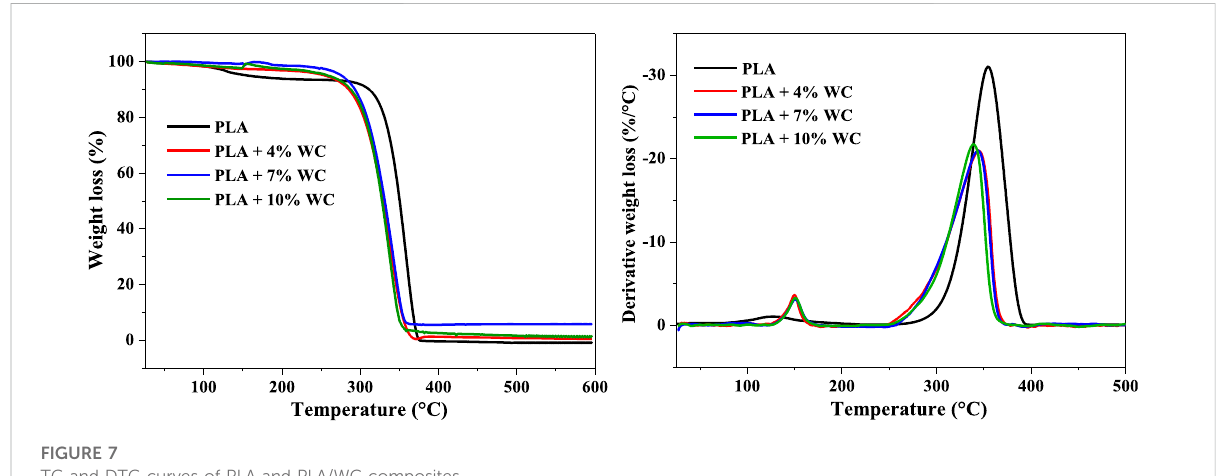
FIGURE 7 TG and DTG curves of PLA and PLA/WC composites.